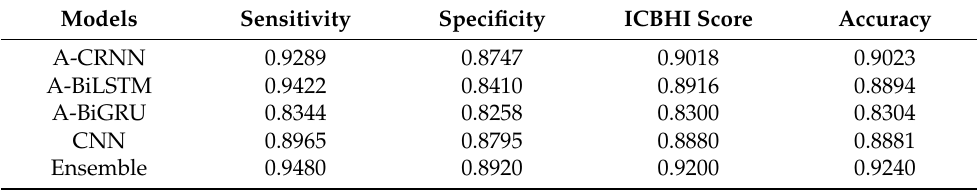
Table 18. Results of base and ensemble models for D3, i.e., the Coswara speech dataset.